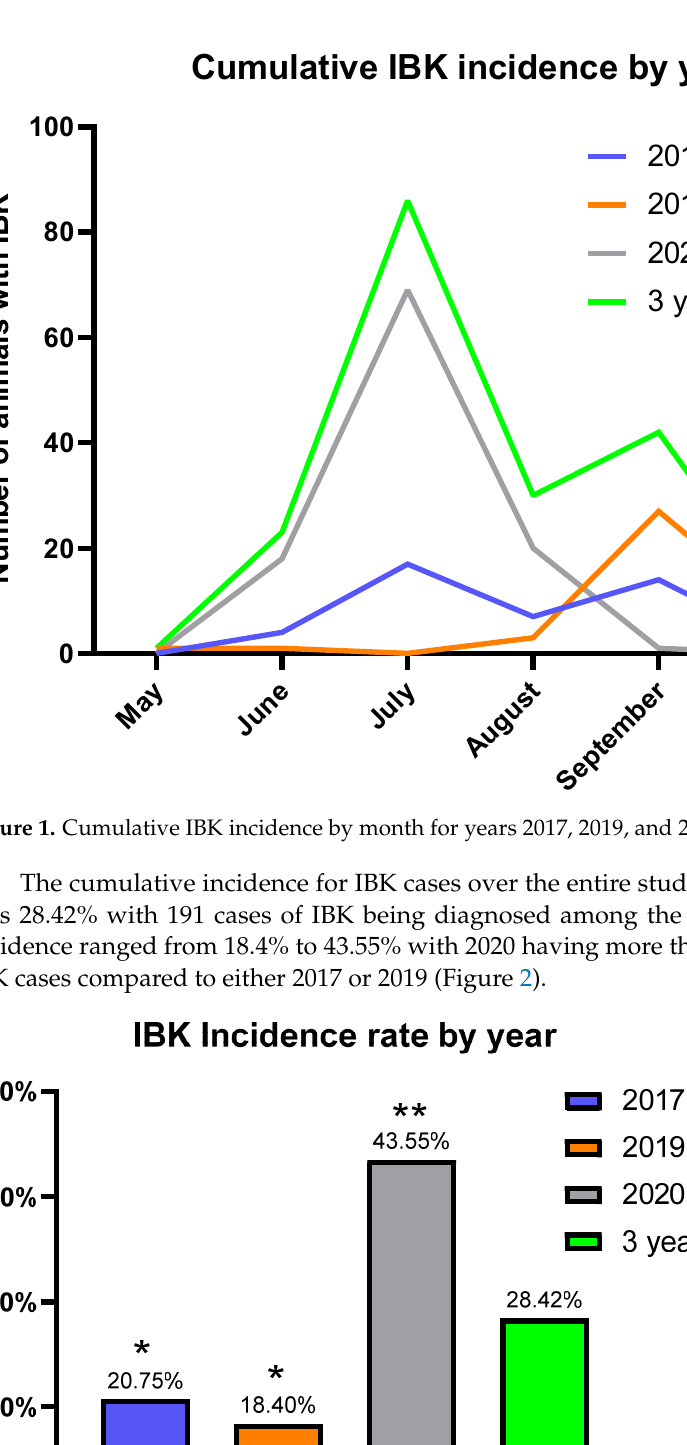
Figure 2. Cumulative incidence of IBK for all calves regardless of vaccine treatment group. Percent- ages calculated as the number of IBK diagnoses per calves enrolled each year. ( p ≤ 0.001). * vs. ** indicates significantly different values.